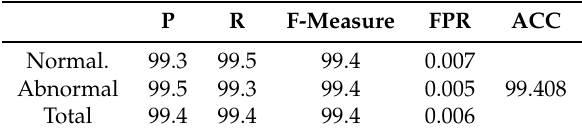
Table 8. Evaluation measures of normal and attacks classification for NSL-KDD dataset. P R F-Measure FPR Normal.